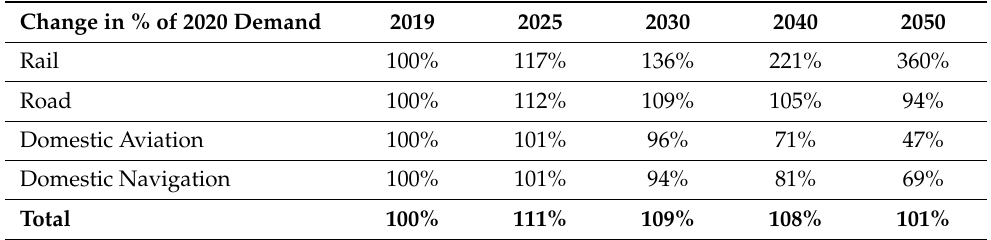
Table 16. Global: Development of behavioral changes in passenger travel (based on pkm) by transport mode.